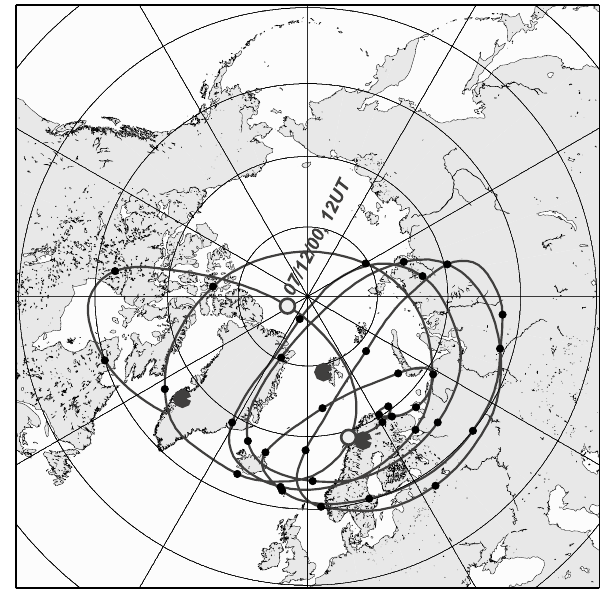
Fig. 6. Nineteen-day forward trajectory of the air parcel examined above Andenes on 20 November 2000, 00:00UT, at about 38km altitude. The trajectory is calculated on the 1250-K-isentropic level. Markers indicate every 12h; circles are at 10 ◦ latitude